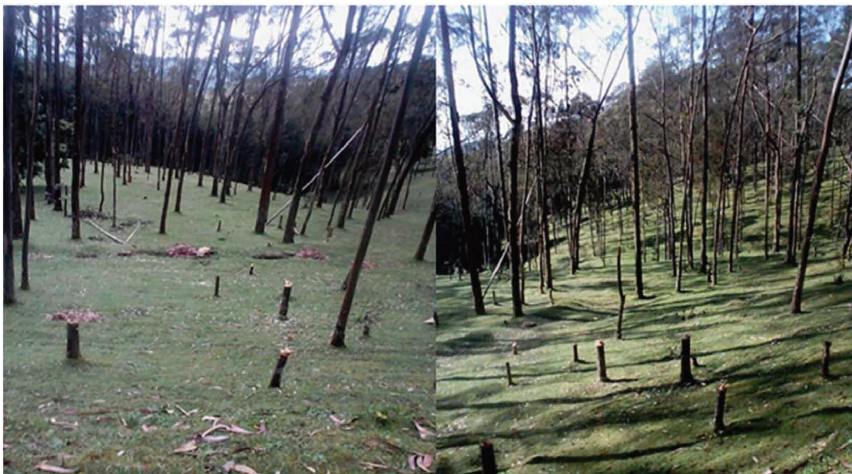
Figure 4: Illegally logged boles (source: feld photo,